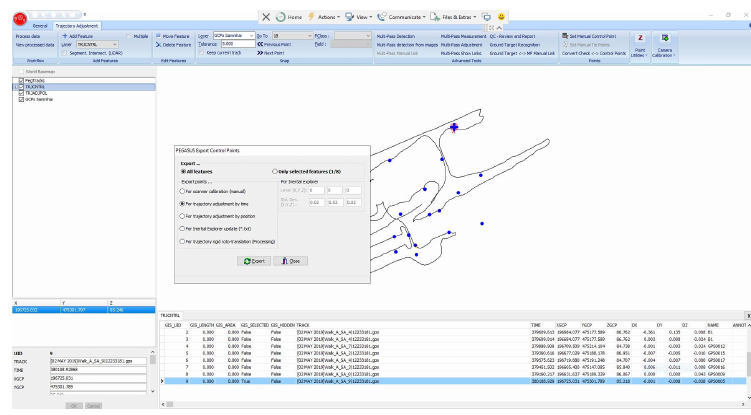
Figure 34. Creating a GIS for the Sânmihaiu Roman Lock.